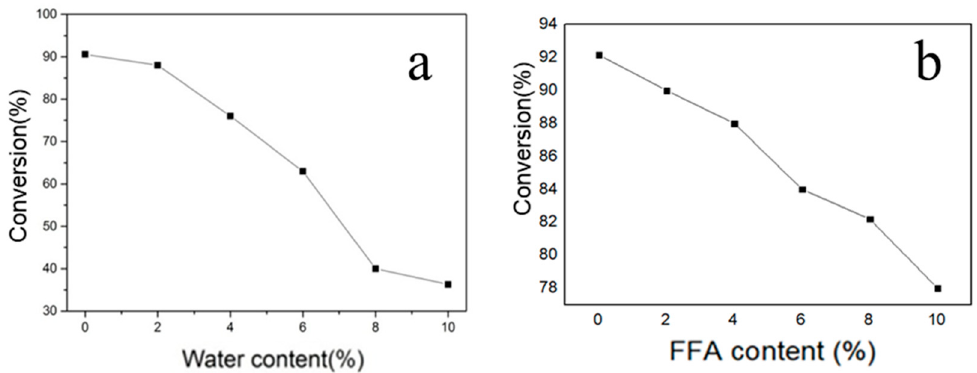
Figure 6. Influence of water ( a ) and free fatty acids (FFAs) ( b ) on the oil conversion over the Cs 2 H 4 PV 3 MoW 8 O 40 catalyst. Cs 2 H 4 PV 3 MoW 8 O 40 catalyst.